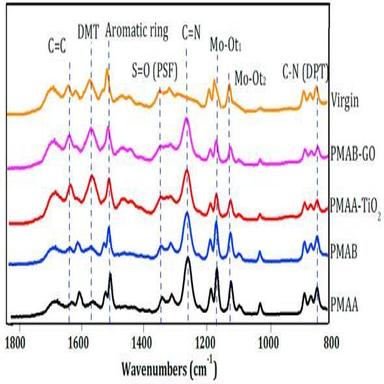
ATR-FTIR spectral data of TFN FO membrane from the top as follows (a) Virgin, (b) PMAB-GO, (c) PMAA-TiO2, (d) PMAB, and (e) PMAA.